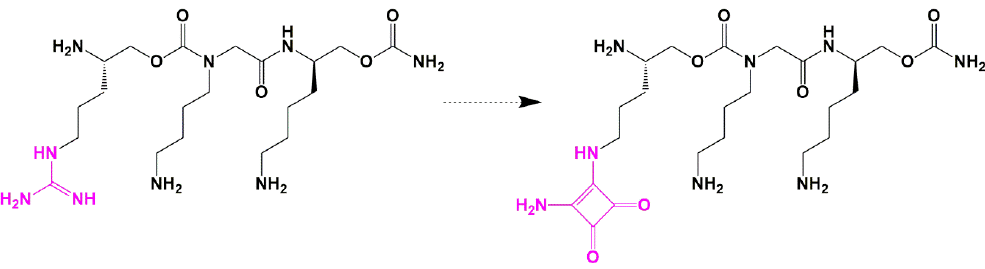
Figure 7. Diaminosquarate bioisostere for the guanidine moiety as a novel HIV-1 Tat-TAR RNA inhibitor.